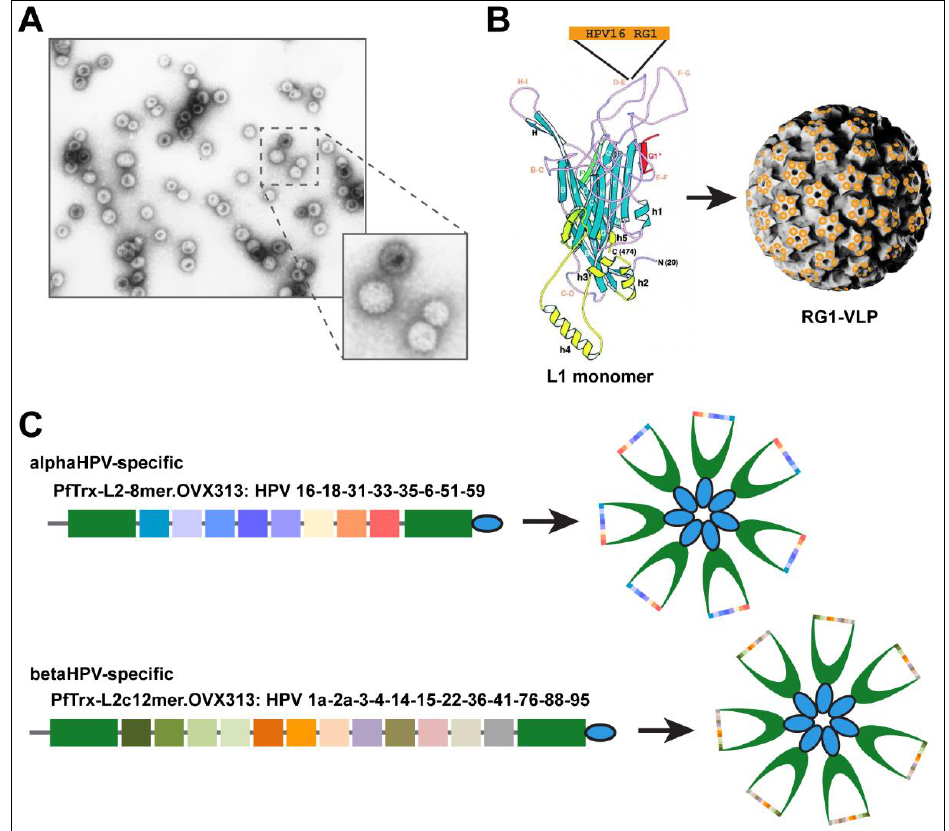
Figure 1. HPV vaccination strategies. ( A ) Electron micrograph of L1 VLPs. ( B ) In HPV16VLP- HPV16RG1, the HPV16 L2-RG1 (aa 17 – 36) is inserted into the D-E surface loop of the HPV16 L1 HPV16RG1, the HPV16 L2-RG1 (aa 17–36) is inserted into the D-E surface loop of the HPV16